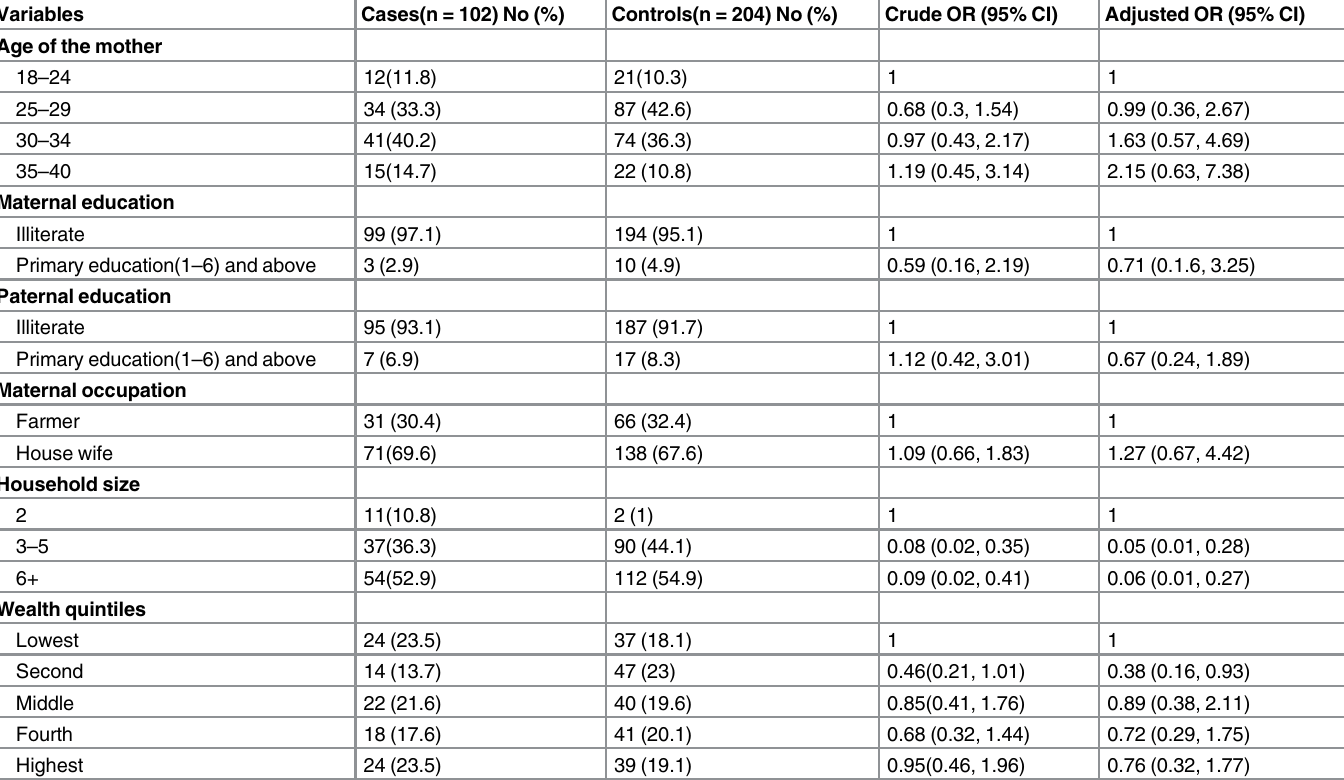
Table 2. Socio-economic and demographic factors associated with perinatal mortality in west Gojam zone, Ethiopia Feb 2012(n =